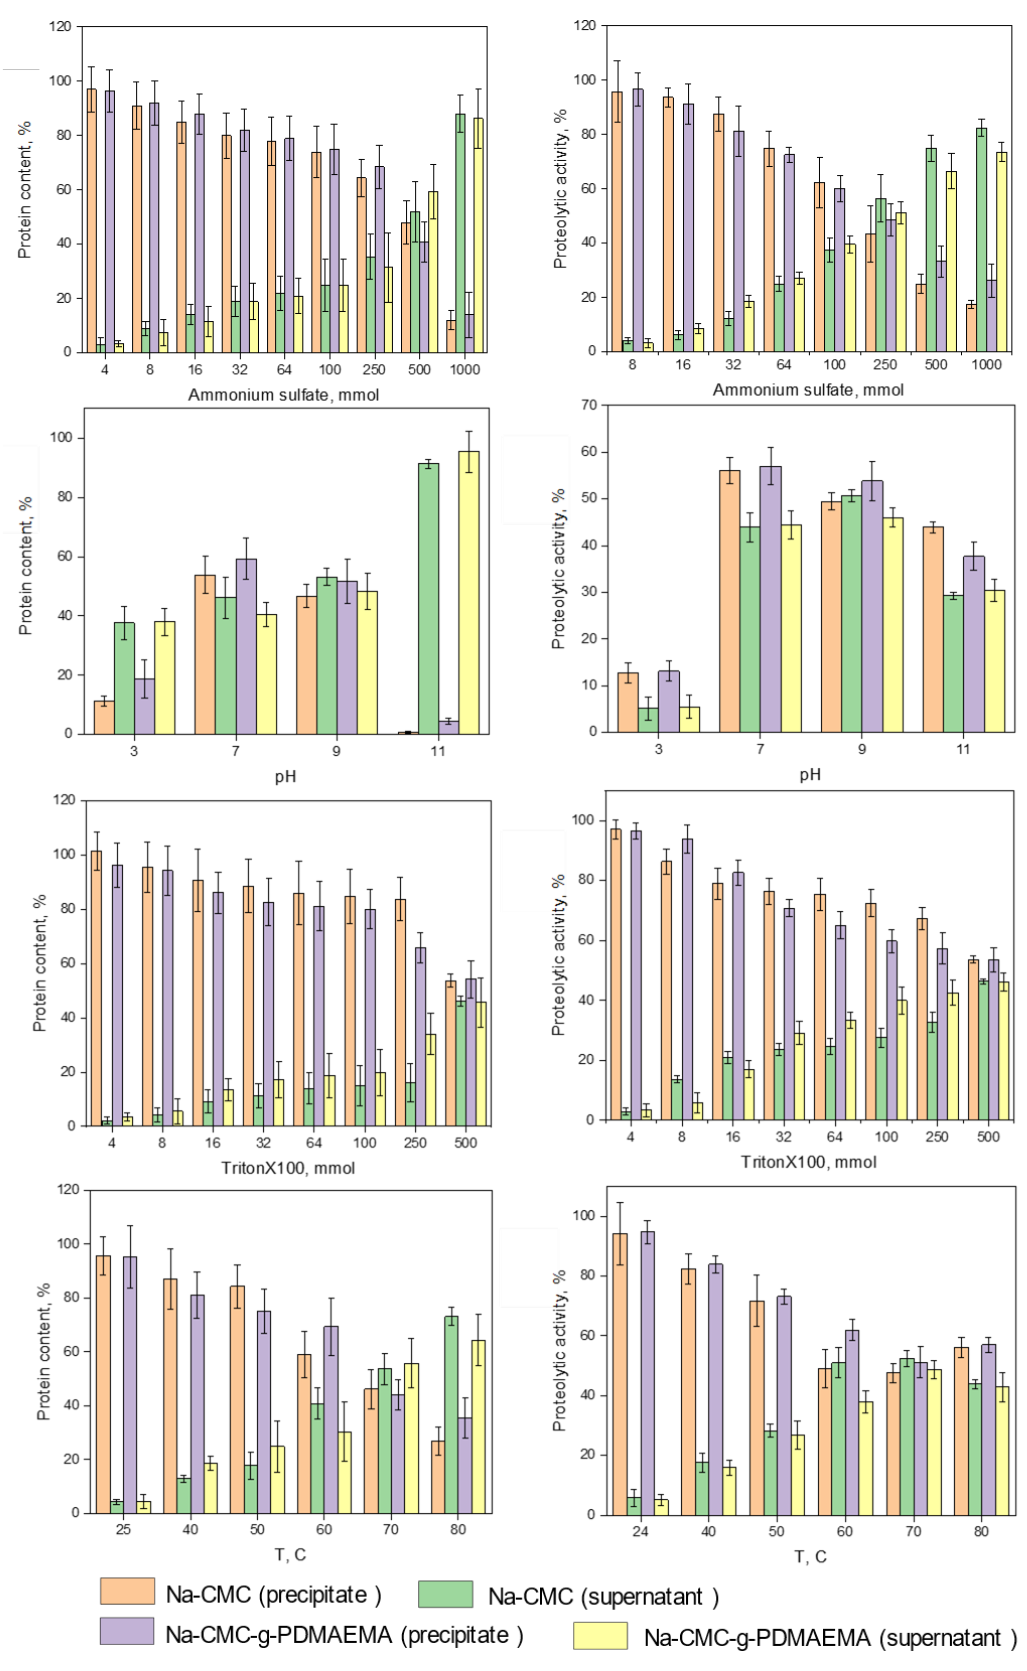
Figure 5. The results of ficin release experiments performed in different conditions.